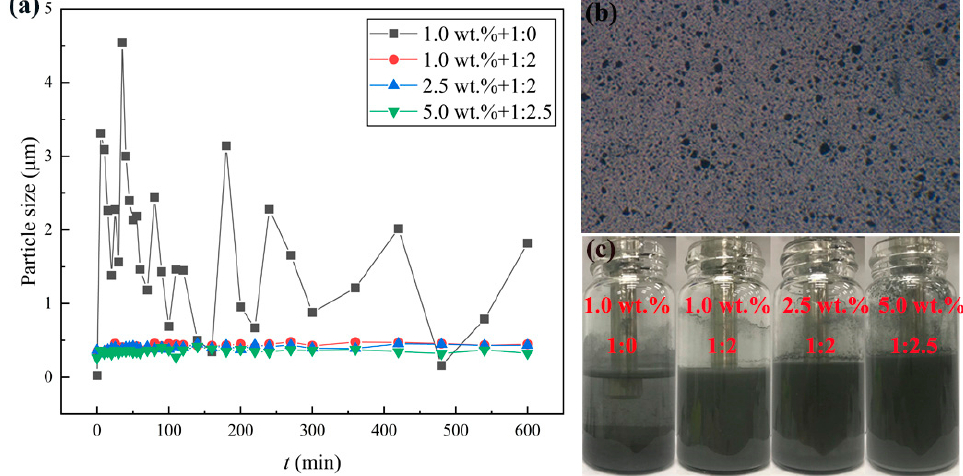
Figure 4. Stability of nanofluid fuels. ( a ) Particle size varies in the suspensions, ( b ) microscopic pic- ture, ( c ) settling pictures after 9 h. picture, ( c ) settling pictures after 9